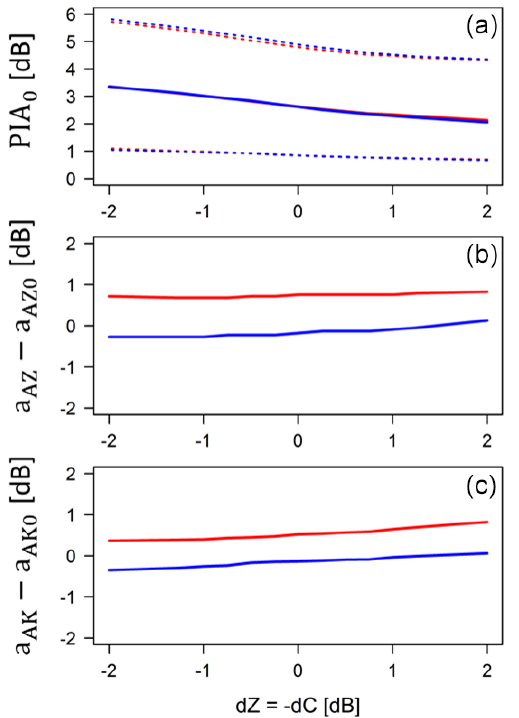
Figure 7. Evolution of the medians of the distributions of on-site attenuation (a) , prefactor of the A – Z relationship (b) and prefactor of the A – K dp relationship (c) estimated for the 21 July 2017 event as a function of the calibration error. The variable dZ , equal to dC , is used to represent the dBZ value to be added to the measured re- flectivities for correcting the calibration error. The prefactors, ex- pressed in dB, are calculated with respect to the central values of their intervals of variation as follows: a AZ 0 = 10log ( 1 . 010 − 4 ) and a AK 0 = 10log ( 0 . 3 ) (Table 1). As in Fig. 4b, the red curves corre- spond to b AK = 1, and the blue curves to b AK = 1 . 1. The dotted red and blue curves in the top graphs represent the 25% and 75% quantiles of the distributions of PIA 0 .